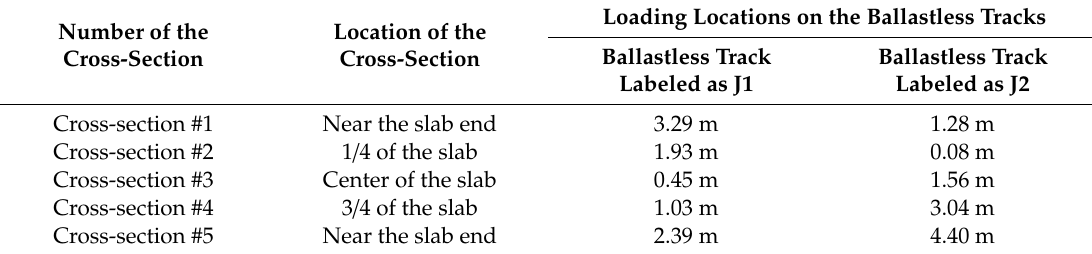
Table 1. Distance between the measuring sensors and the loading positions (m).